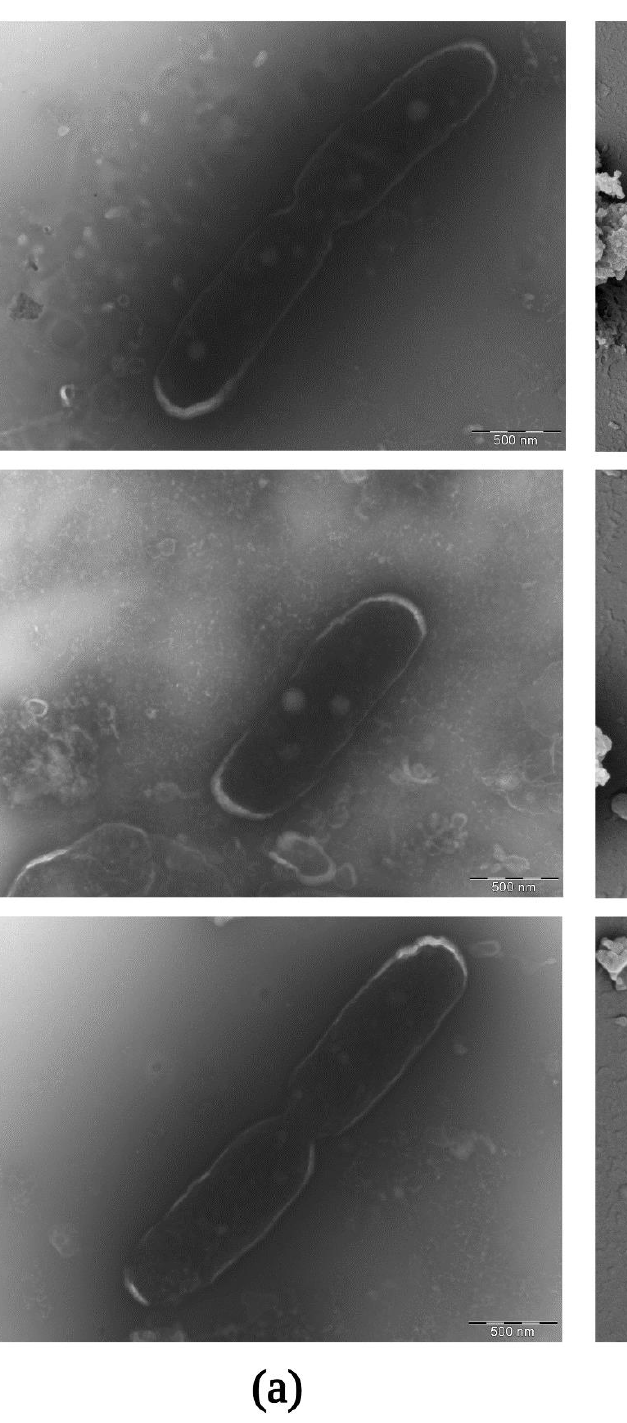
Figure 7. Visualization of purified R. felis Danube by electron microscopy. Negative staining of rick- ettsial binary fission captured by transmission electron microscopy ( a ). Scanning electron microscopy of purified and glutaraldehyde-fixed R. felis sedimented onto circular coverslips and silicon wafer ( b